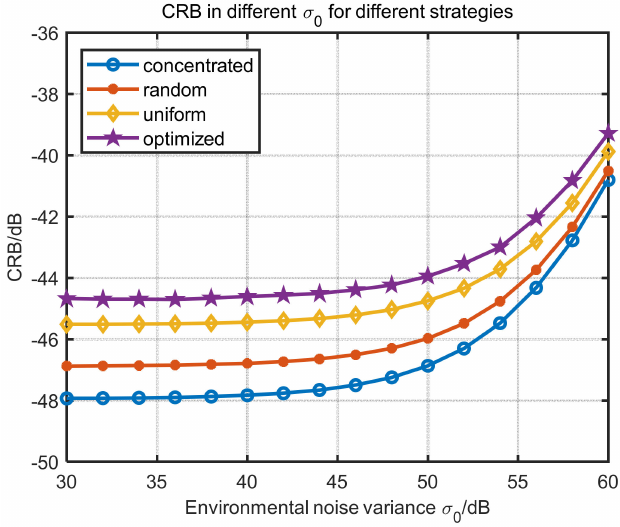
Figure 7. CRB under di ff erent environmental noise for di ff erent strategies in a multitarget